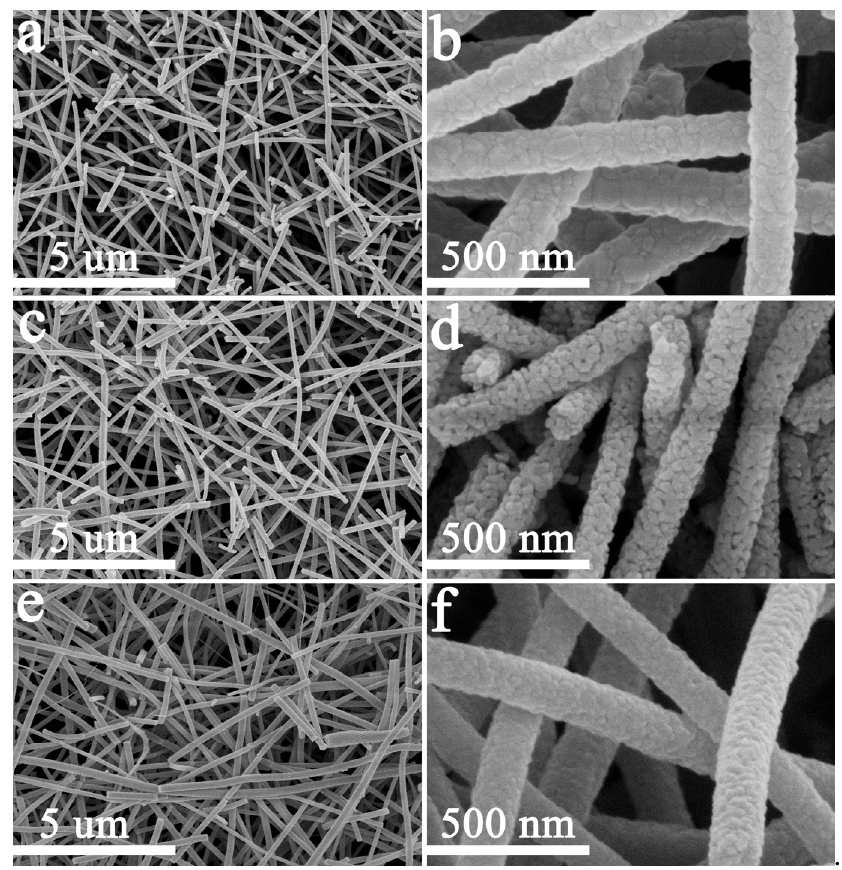
Figure 6. Field ‐ emission scanning electron microscope （ FE ‐ SEM ） images of ( a , b ) pristine TiO 2 ( c , d ) 3 wt.% Ni-doped TiO 2 nanofibers; and, ( e , f ) 6 wt.% Ni doped TiO 2